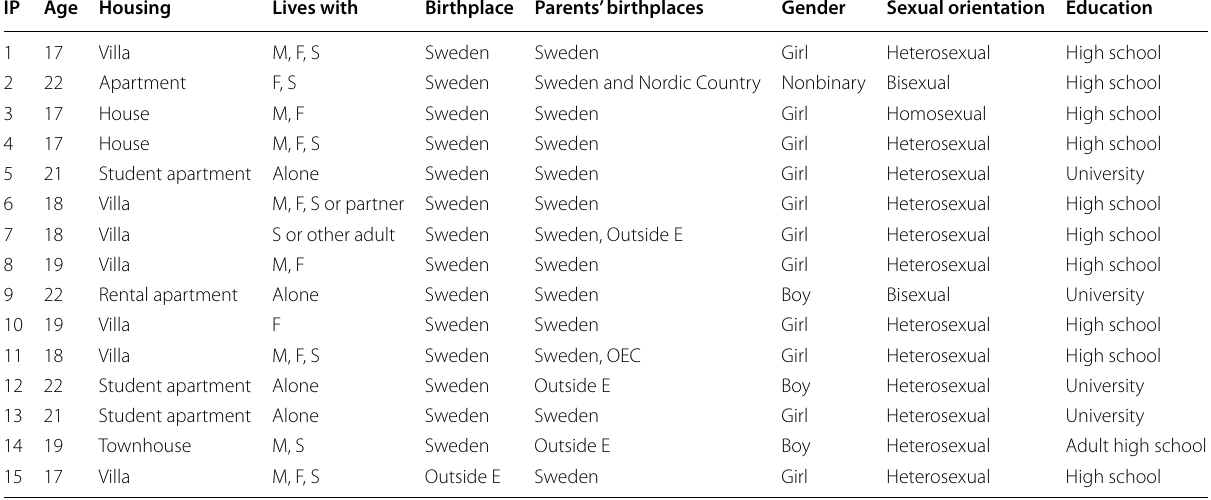
Table 3 Participants’ demographic information